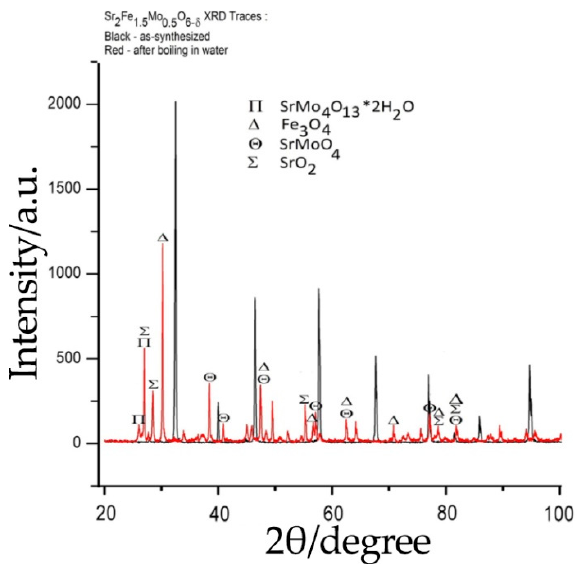
Figure 14. XRD patterns of Sr 2 Fe 1.5 Mo 0.5 O 6– δ before and after its treatment in a boiling water. Reproduced with permission [128]. Copyright 2013, Elsevier.